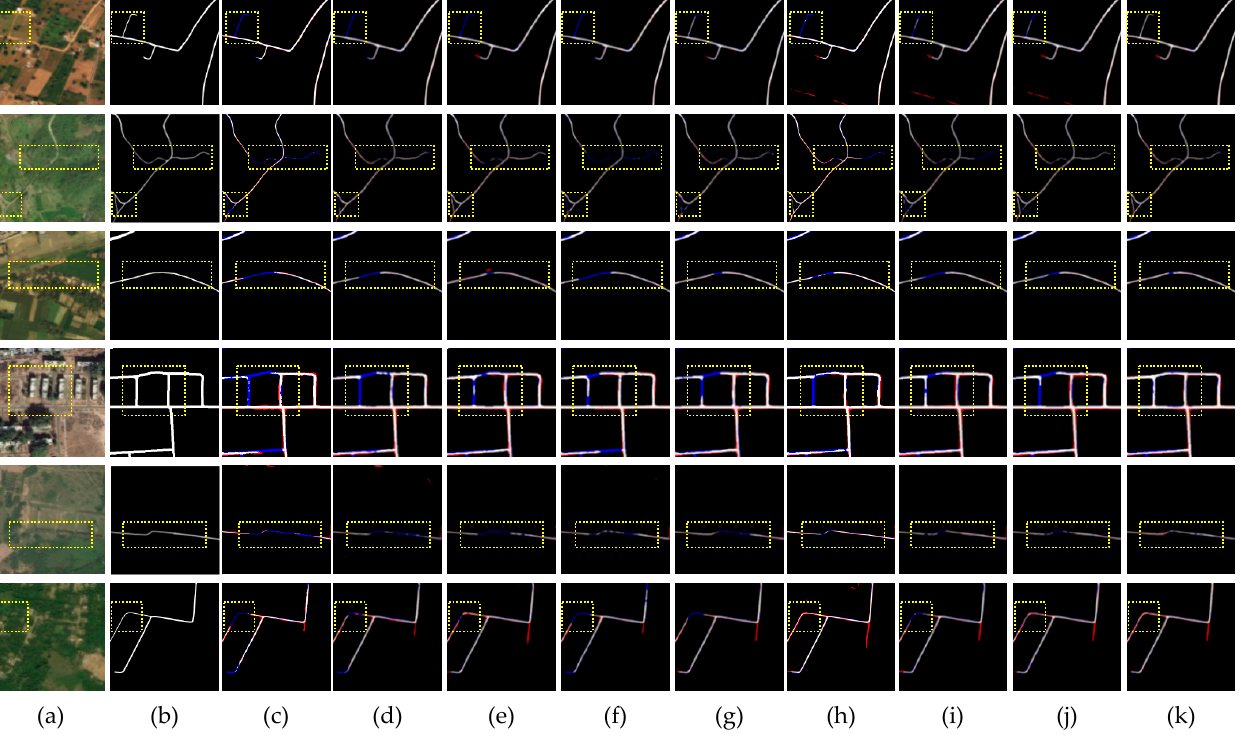
Table 1. Quantitative evaluation results of different networks on the DeepGlobe